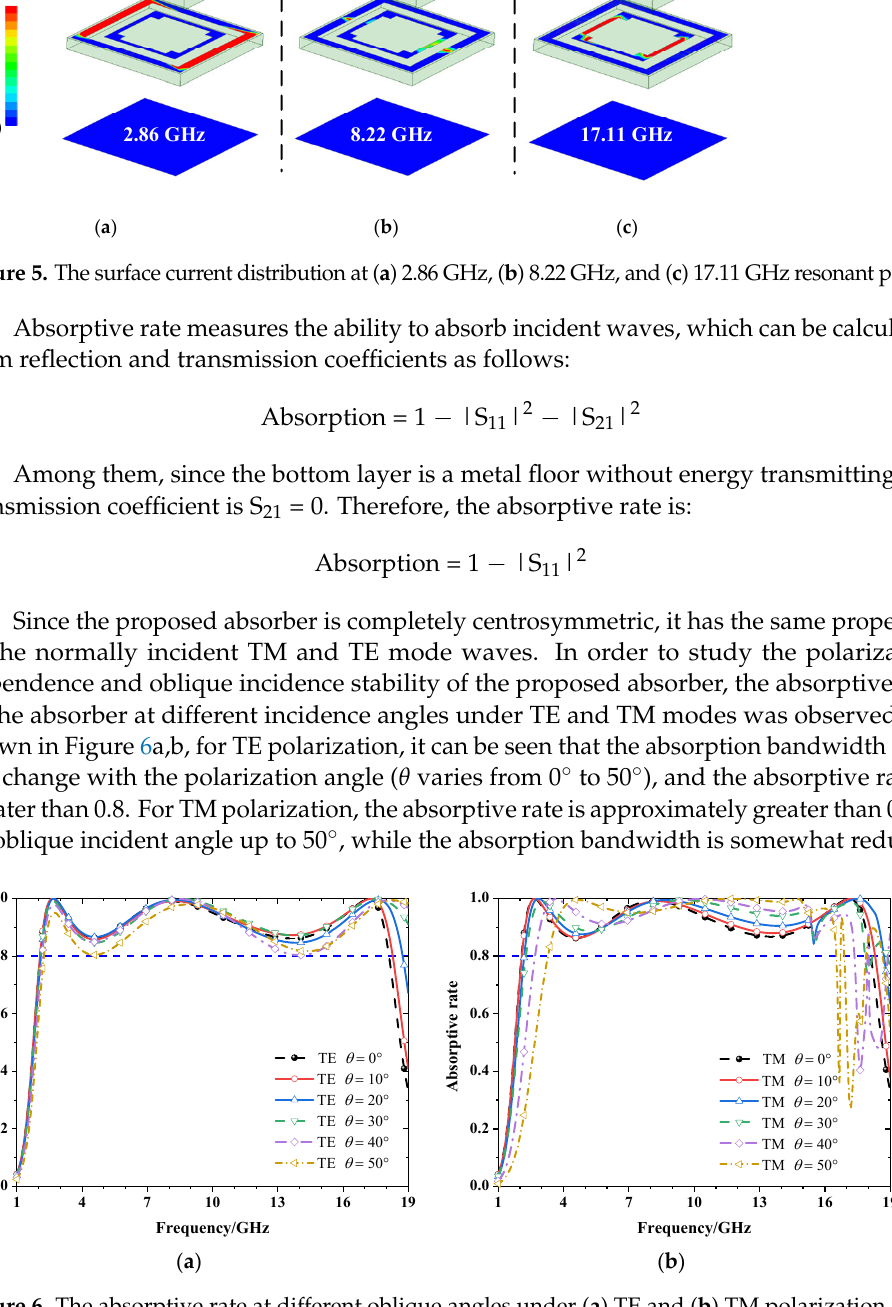
(f) Horn Absorbers Figure 7. The fabricated prototype and measurement environment. ( a ) the photo of the assembled whole prototype, the front view of ( b ) Layer 1 and ( c ) Layer 2, the detailed unit photo of ( d ) Layer 1 and ( e ) Layer 2, ( f ) the measurement environment configuration. The measured absorptive rate results under two polarizations at the oblique incident angle of 10°–50° are shown in Figure 8. Because there is at least an 8° angle between two rocker arms, the ideal normal incident cannot be measured accurately. According to the measured results, it can be observed that the absorptive rates are above 0.8 and within